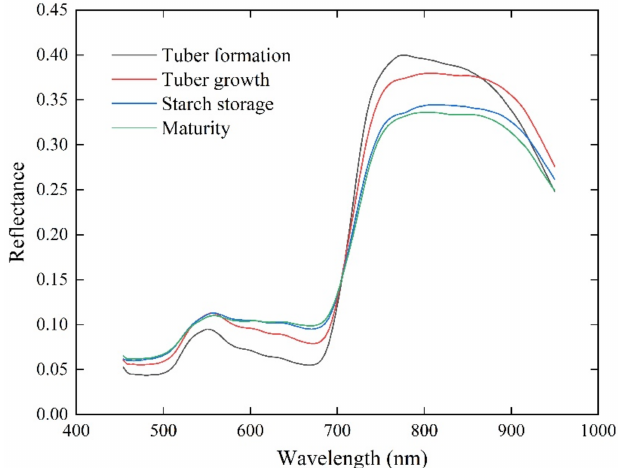
Figure 4. Canopy spectral reflectance of potato in four key growth